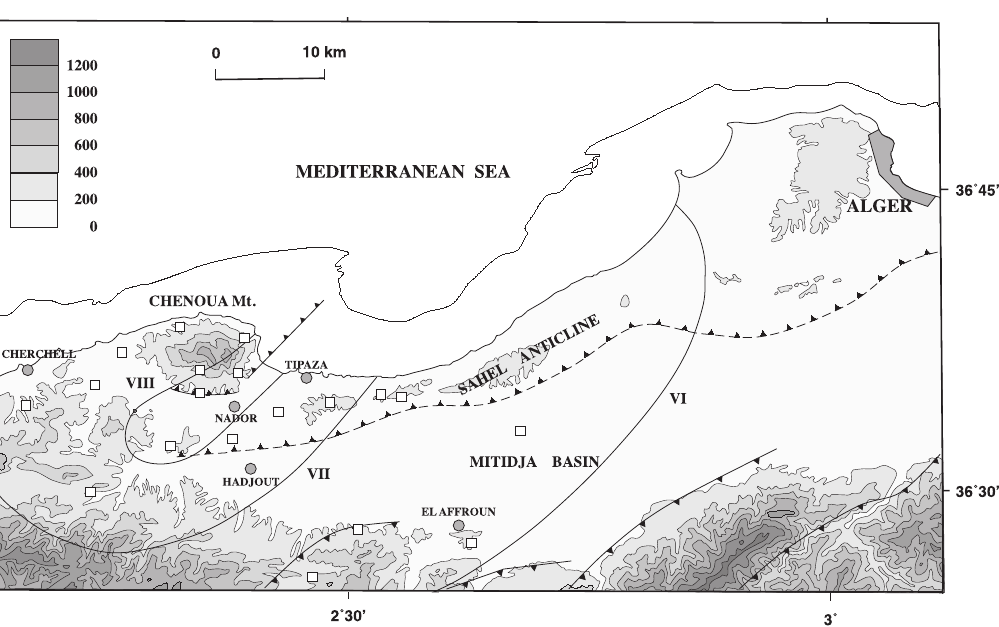
Fig. 1. Topographical and tectonical features of the region of the Chenoua earthquake. Isobath 200 m is shown. Main faults from Meghraoui (1988). Isoseist lines from Yelles-Chaouche (1991). Open squares: seismological